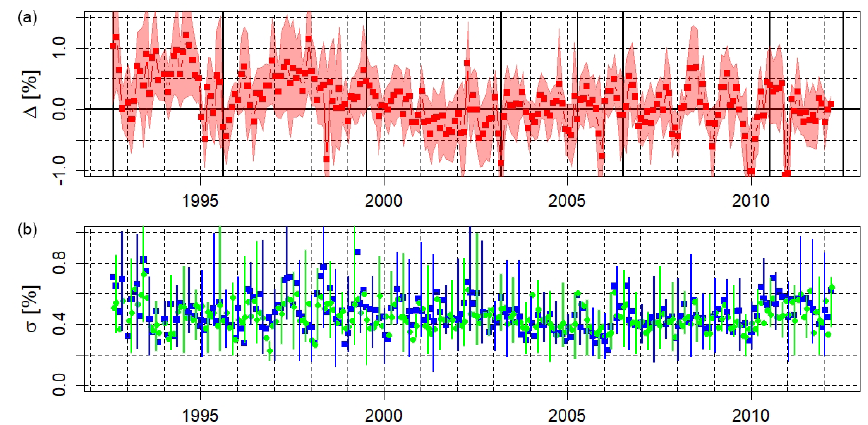
− δ D (a) and the individual 062 101